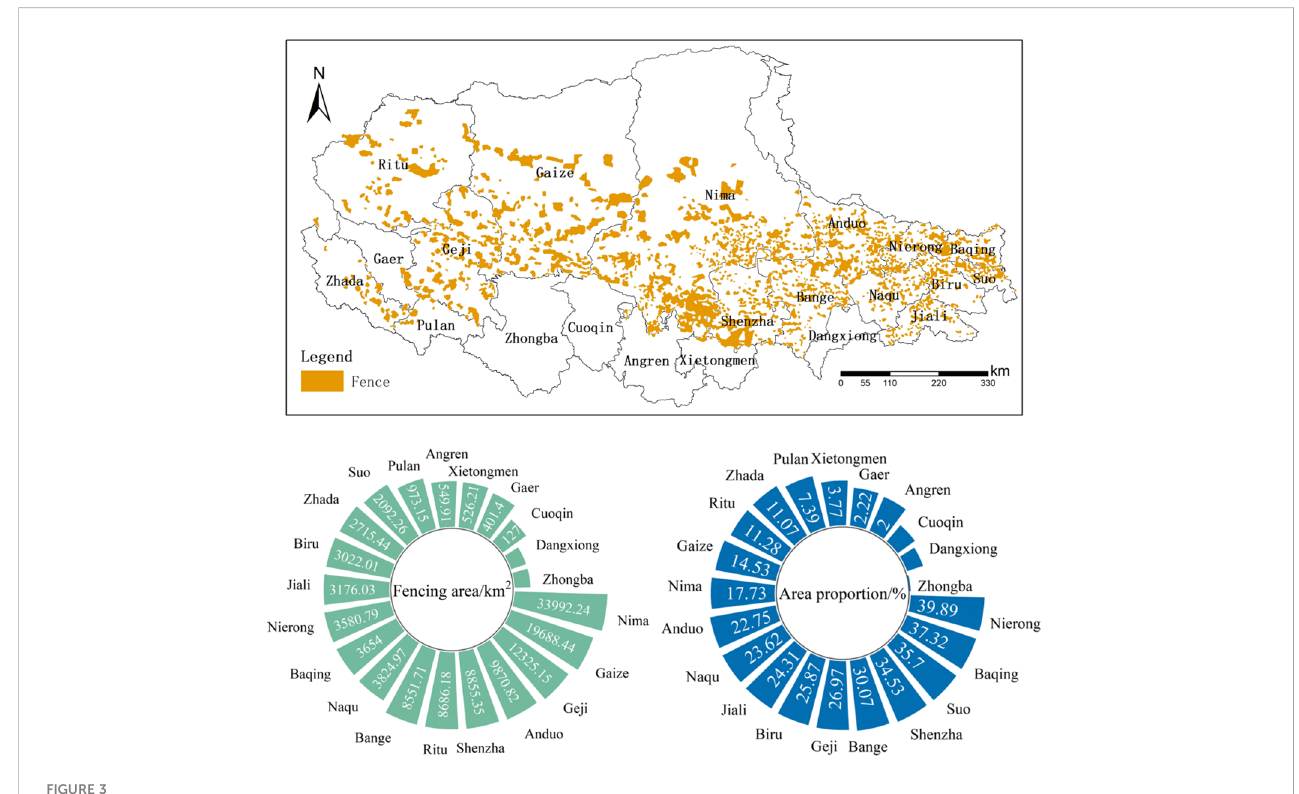
FIGURE 3 Fencing area and proportion by